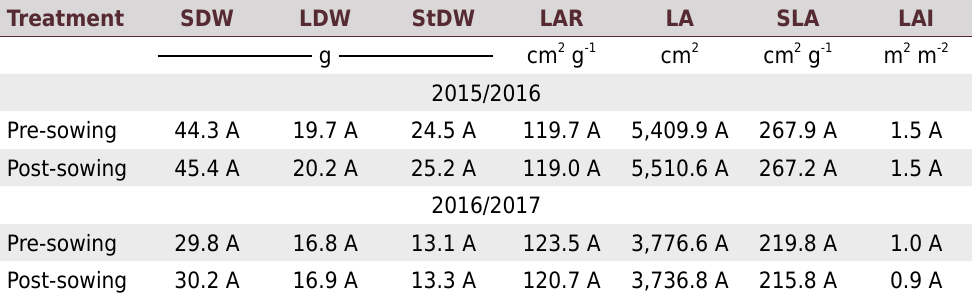
Table 2. Means of biometric parameters for the factor application period Treatment SDW